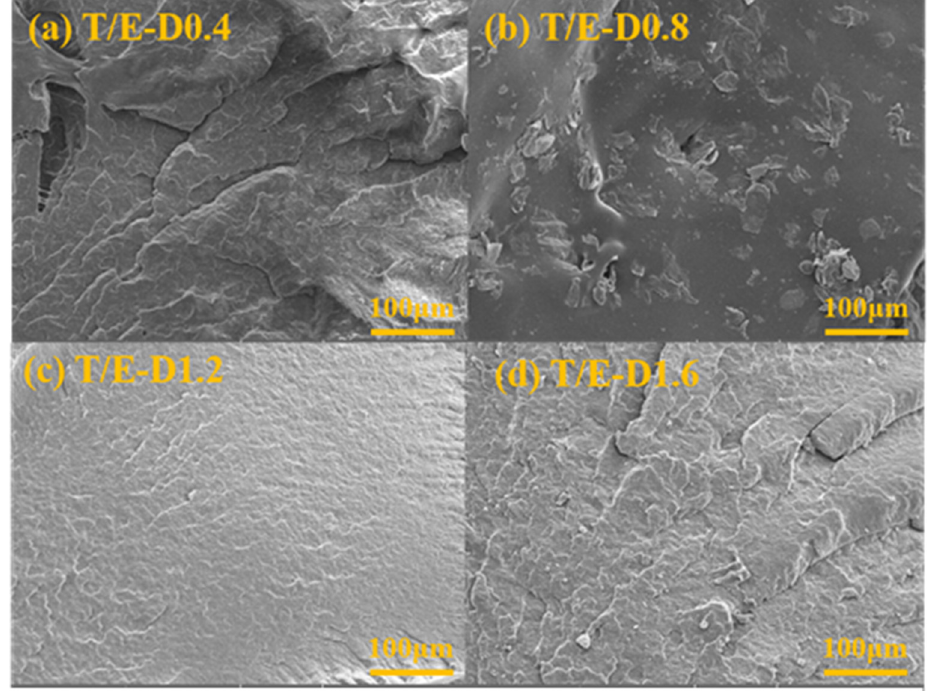
Figure 2. SEM micrograph of the cryogenically fractured surface of TPI/EVA composites with different DCP contents: ( a ) T/E-D0.4; ( b ) T/E-D0.8; ( c ) T/E-D1.2; ( d ) T/E-D1.6.